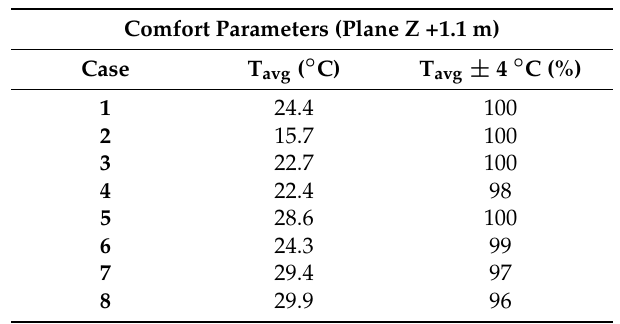
Table 4. Temperature parameters at surfaces.